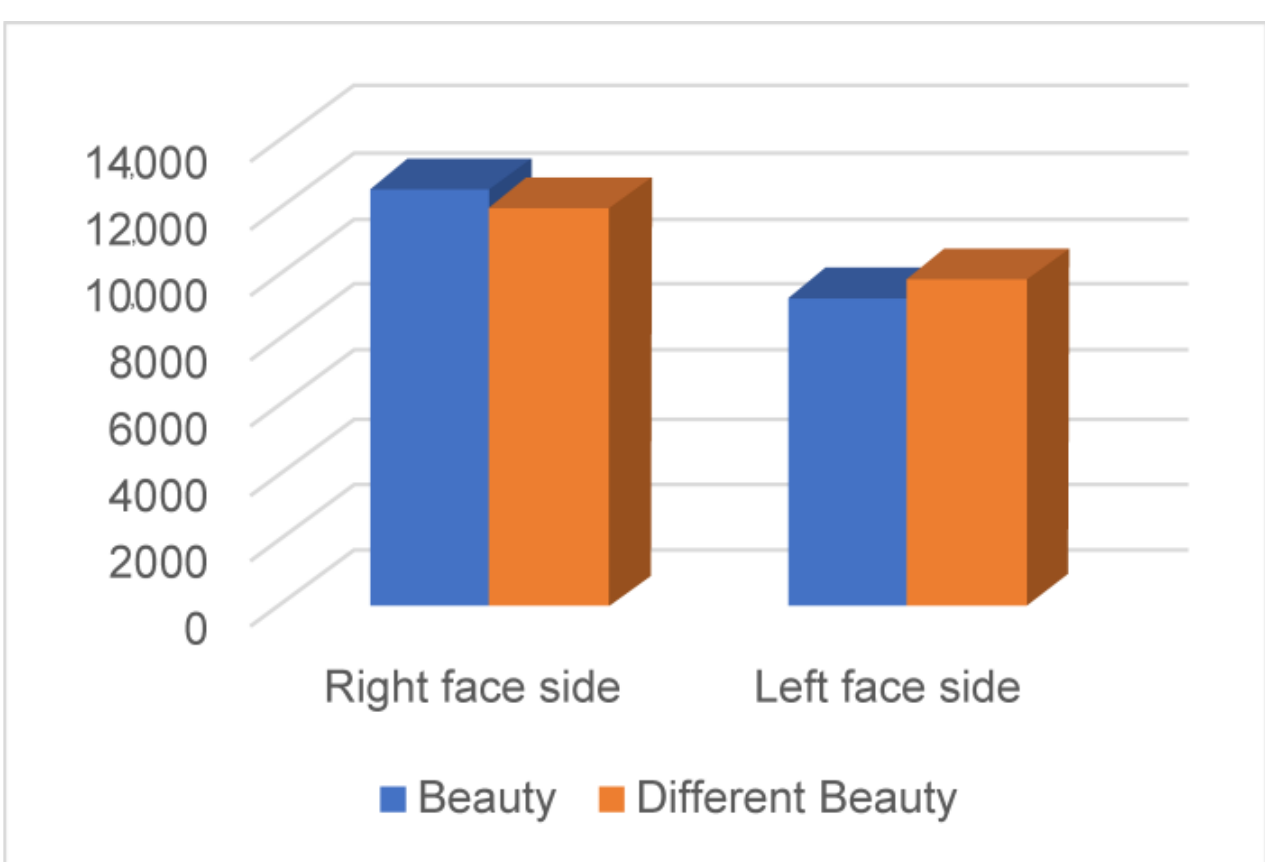
Figure 8. Face’s side correlation with machine’s sentiment decisions.